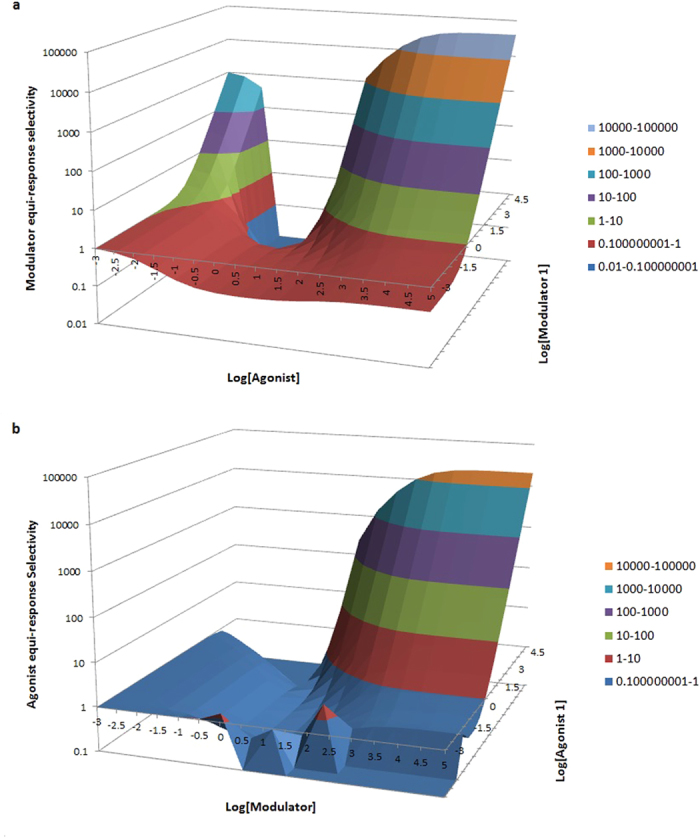
Modulator or agonist equi-response selectivity 3D plots.All simulations for 3D surface contour plots of modulator (a) or agonist (b) equi-response selectivity use the following parameters values: KA1 = KA2 = 100 nM, chi1 = chi2 = 0.01, tauA = tauA2 = 3, n1 = n2 = 1, KB1 = 50nM, KB2 = 100nM, tauB1 = 0.1, tauB2 = 0.2, aa1 = 100, aa2 = 10, bb1 = 2, bb2 = 6, RR = 1.